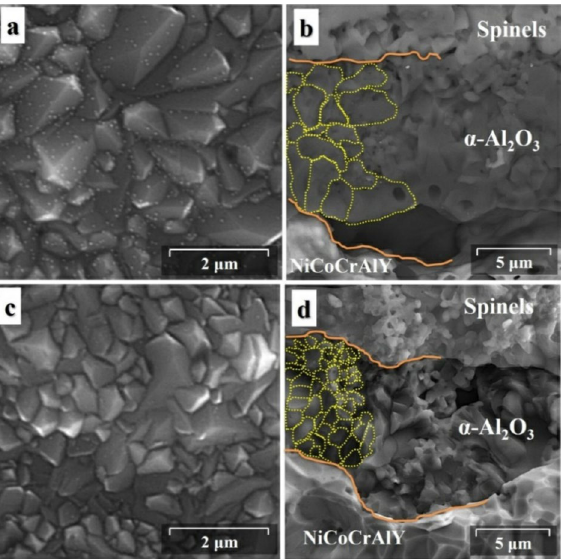
Figure 19. The top and the cross-sectional view of the morphology of the oxide scale formed on the conventional ( a , b ) and nanocrystalline ( c , d ) coatings after long-term oxidation at 1000 °C after 1000